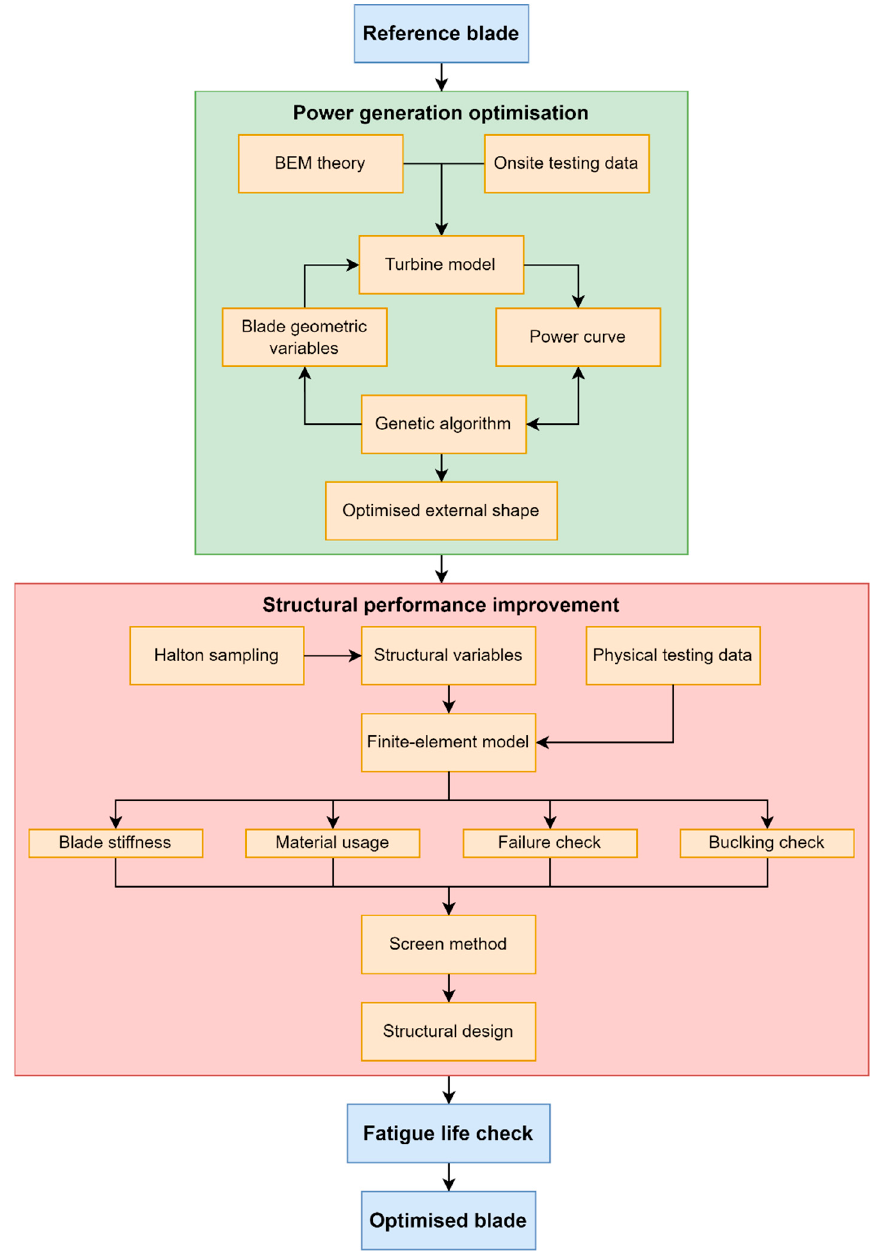
Figure 1. Methodology for improving blade efficiency for an existing wind turbine.